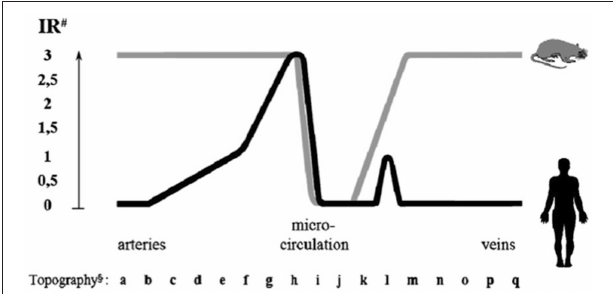
FIGURE 3 | Endothelial ACE distribution along the human and rat vascular tree. Endothelial ACE is heterogeneously distributed in humans (black line). Large arteries contain no or little ACE while maximal ACE content is observed in small muscular arteries and arterioles. Only a fraction of capillaries network contains ACE. Venules and veins contain no or little ACE except some muscular veins in upper and lower extremities. Exceptions to this general scheme are the renal circulation and the pulmonary capillary network (not shown, see text for discussion). In the rat (gray line) ACE is more homogeneously distributed in arteries and veins, while only a fraction of capillaries contains ACE, like in man. ACE is also dowregulated in renal arterioles (not shown). # Immunoreactivity (IR) shown is scored from 0 (no reactivity detectable) to 3 (maximal reactivity) and refers to defined mAb concentrations. § Localization of endothelial cells: (a) aorta ascendens, arcus aortae, aorta descendens/thoracalis/abdominalis; (b) a. brachiocephalica,